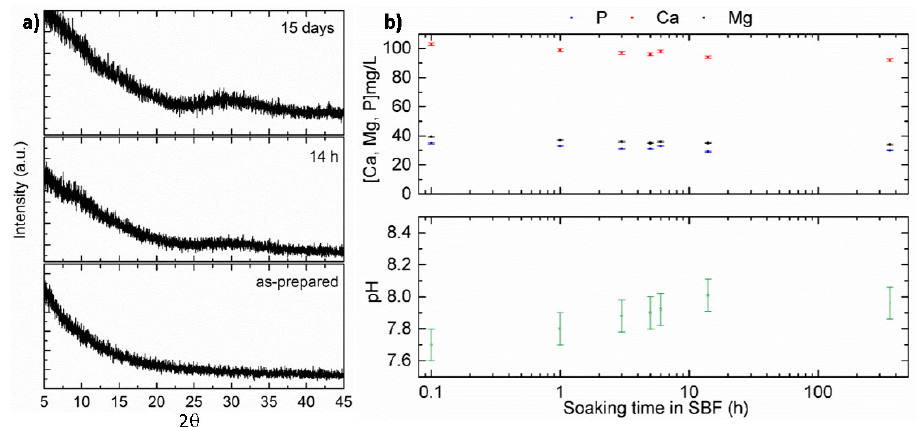
Figure 2. ( a ) XRD patterns of as-prepared SiOC powders ( bottom ) as well as after soaking in SBF [28]